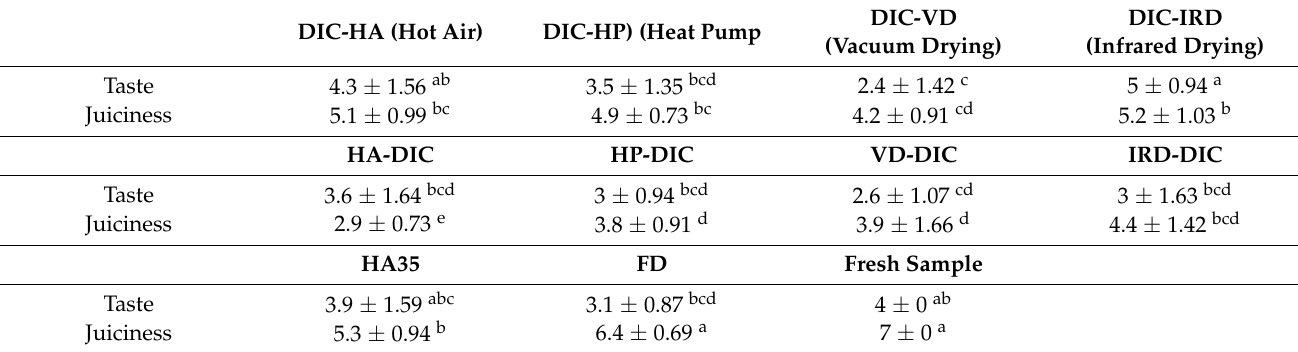
Table A1. Sensory evaluation of DIC combined drying at 35 ◦ C.